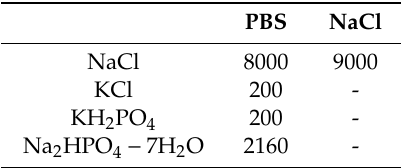
Table 4. Formulation of phosphate-bu ff ered saline (PBS) and NaCl solutions.